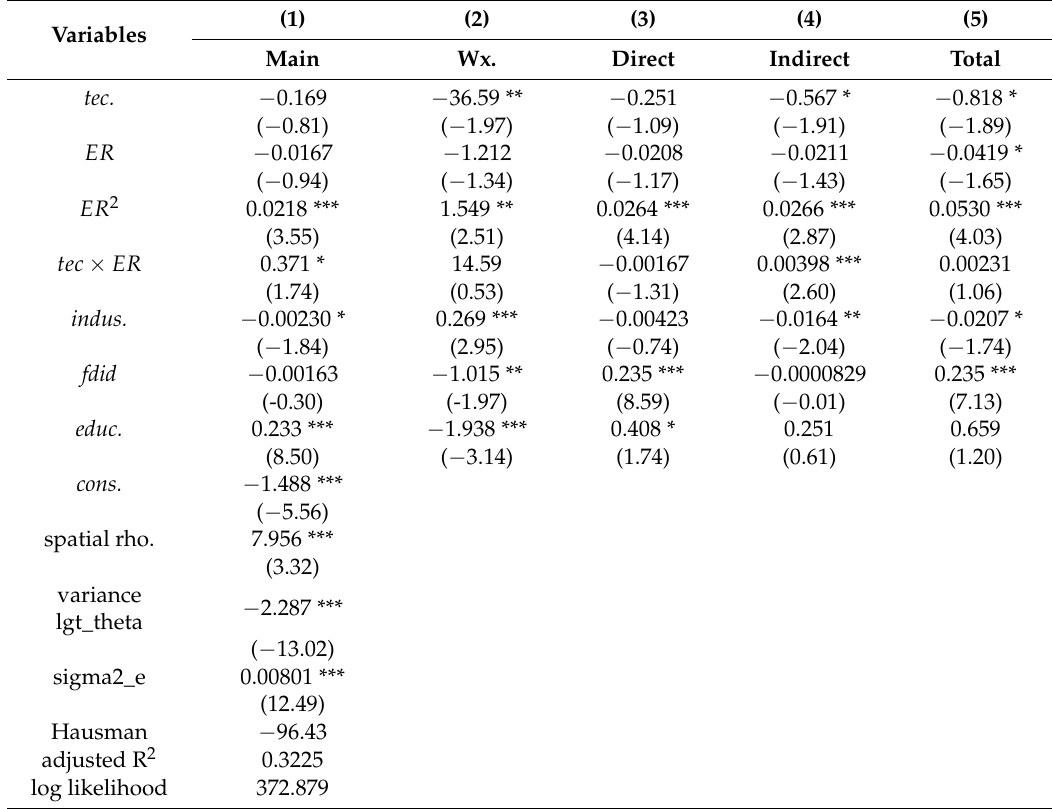
Table 4. SDM regression